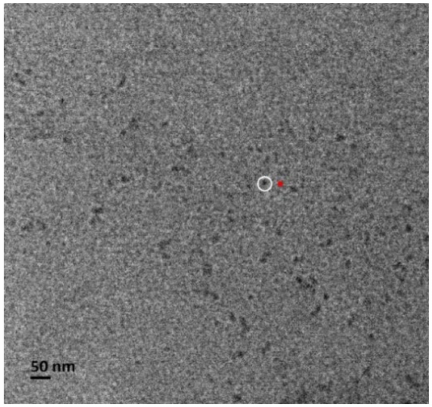
Figure 5. Transmission electron microscope image of CQDs. The diameter of the red dot in the figure is about 10 nm, which is similar to the size of the carbon quantum dot marked by the white